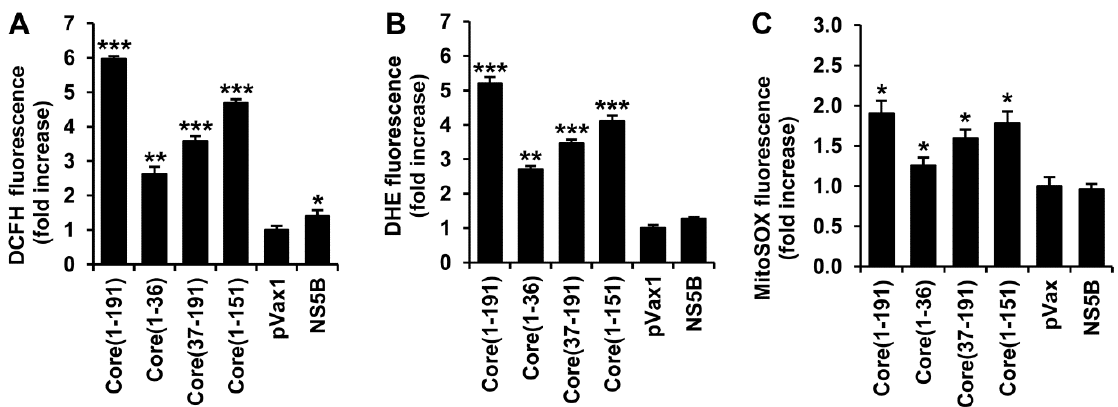
Figure 2. Cont Figure 2. Cont .